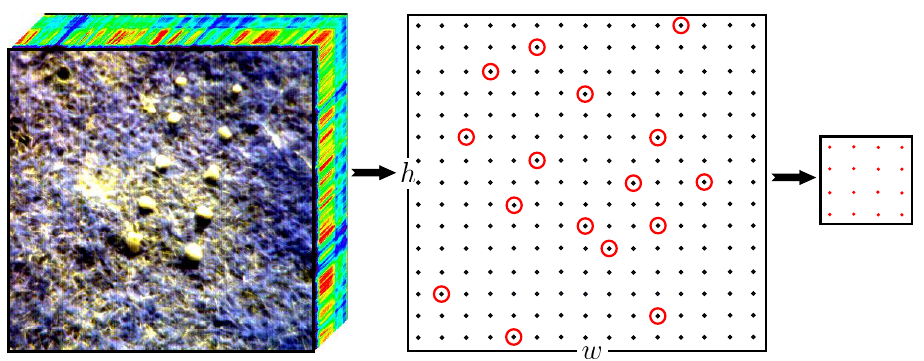
Figure 2. Random background modeling of the ensemble and random collaborative representation detector